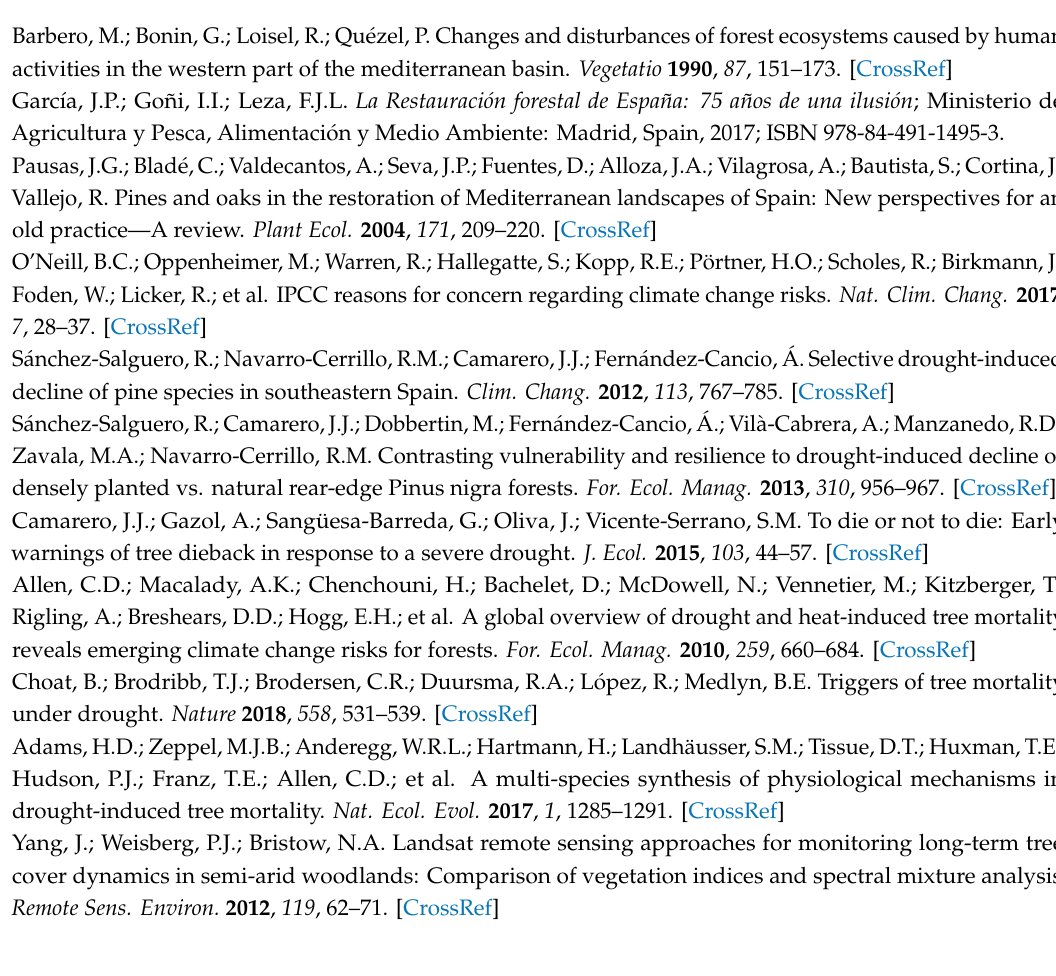
Figure S2. Performance of regression models as a function of training data size used to study the defoliation of Pinus pinaster forests in Sierra de Baza (Andalusia-Granada). (a) Regression model random forest, (b) support vector machines, (c) neural networks, Table S1. Hydrological variables generated from the WiMMed model. In italics, variables obtained from the first and second step of the variable selection procedure (correlation analysis and VIF). In black italic type, chosen variables by VSURF variable selection to build the regression models, Table S2. Relative importance values for hydrological variables according to VSURF variable selection used to assess Maritime pine stands in the decline process in Sierra de Baza (Andalusia-Granada), Table S3. Relative importance values for hydrological variables according to VSURF variable selection used to assess Maritime pine stands in decline process in Sierra de Baza